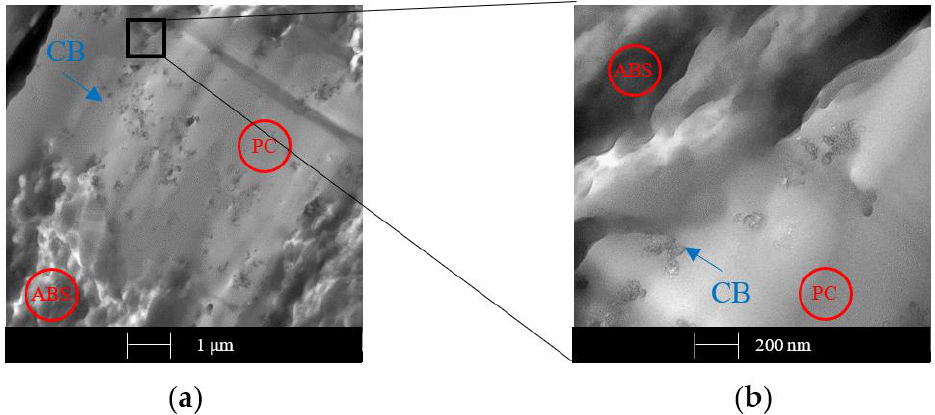
Figure 14. TEM micrographs of sample with 1 wt. % of CB obtained by the melt extrusion method.